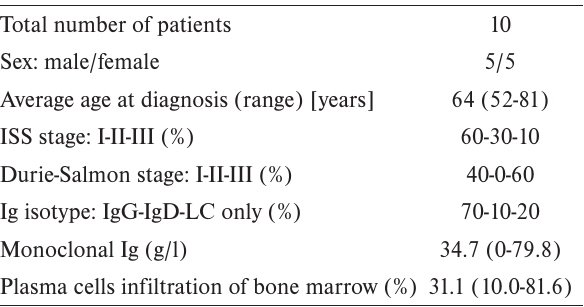
Table 1. Patient’s baseline characteristics.